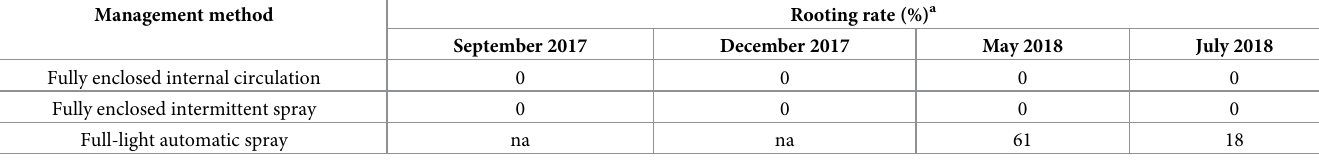
Table 1. Effect of management methods on the rooting rate of PWD resistant Masson pine stem cuttings. Management